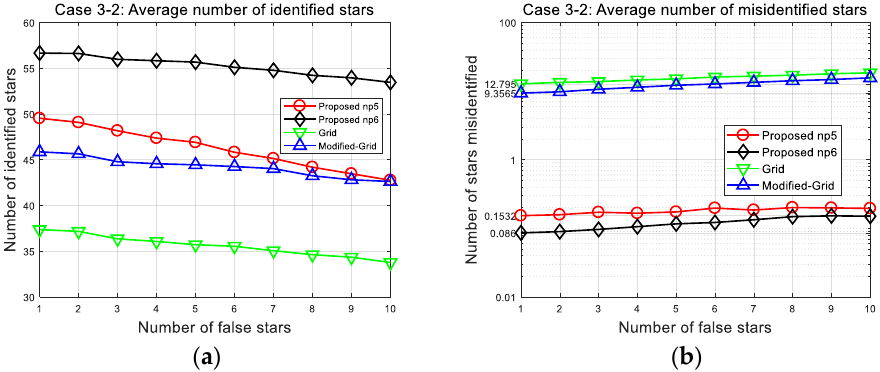
Figure 14. Case 3-2: ( a ) Number of correctly identified stars; ( b ) number of misidentified stars.